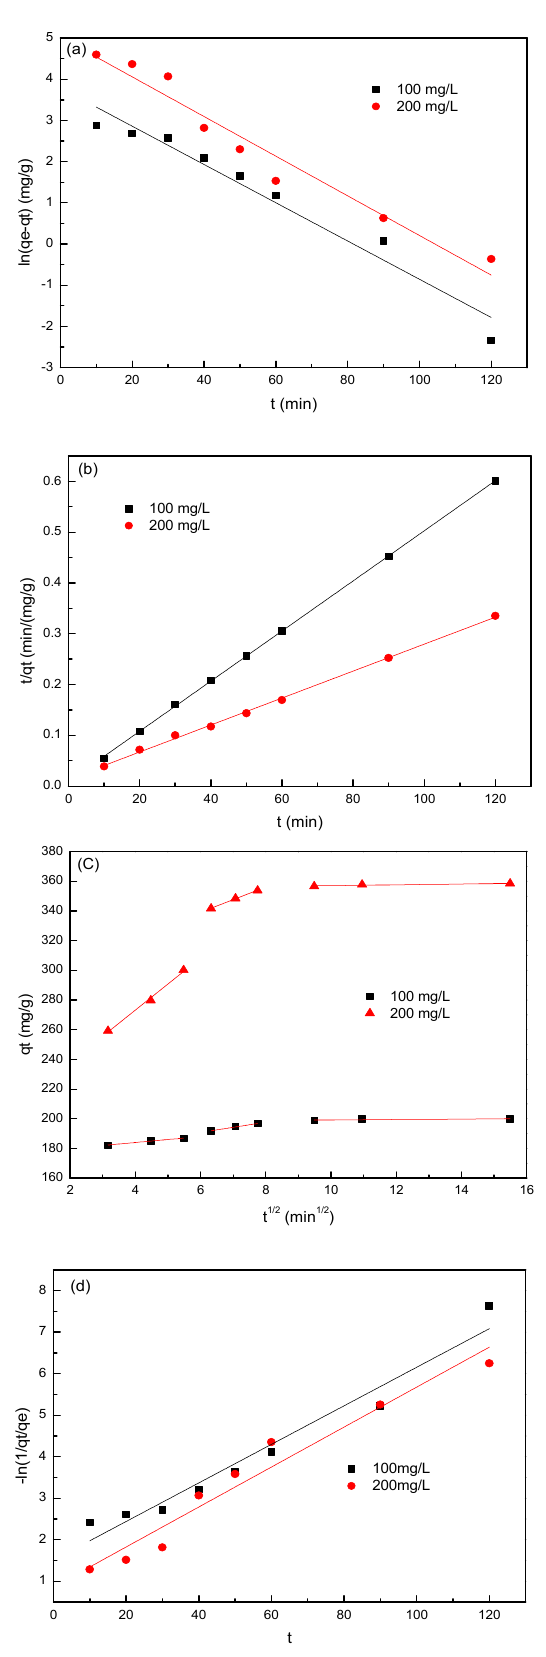
Figure 6. The four kinetic models for the adsorption of SL by 2.8%CB-LDH: ( a ) pseudo-first-order model, ( b ) pseudo-second-order model, ( c ) particle internal diffusion, and ( d ) liquid film diffusion. Table 2. Parameters of the four dynamics models.